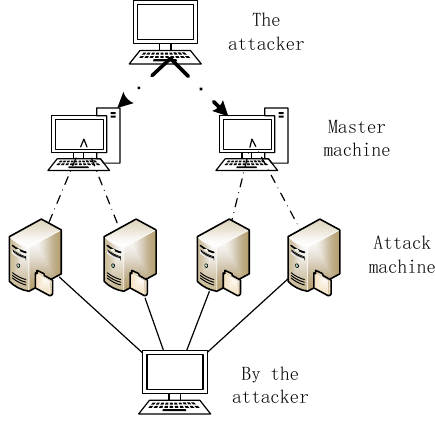
Figure 1. Schematic diagram of a DDoS attack.